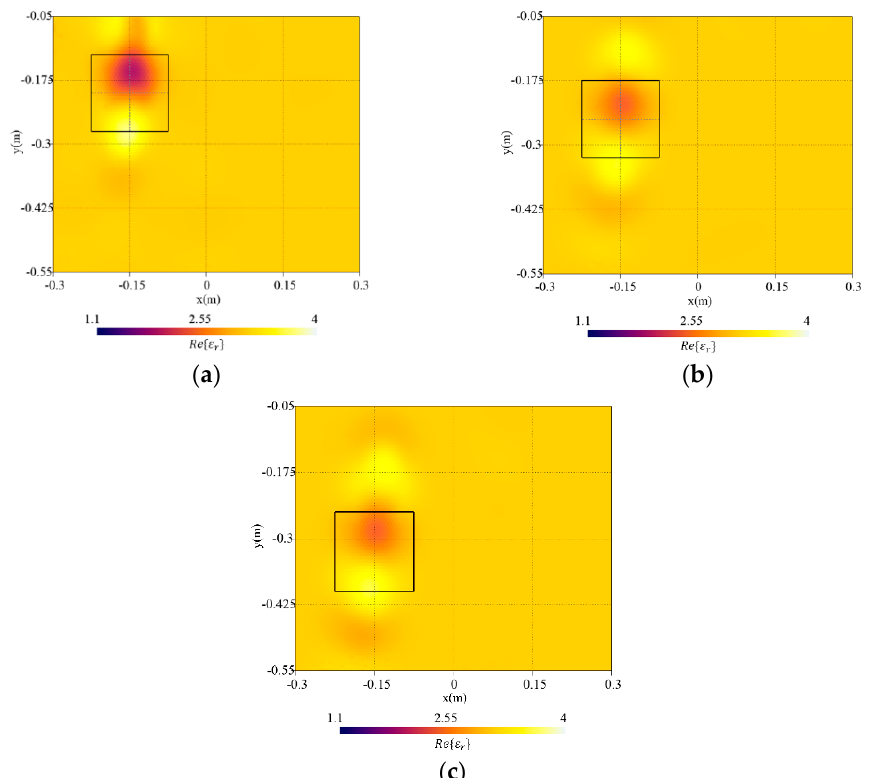
Figure 9. Reconstructed distribution of the real part of the reconstructed relative dielectric permittivity, Re { ε r } , in the investigation domain R together with a square box indicating the shape of the actual target. Target centered at ( a ) y t = − 20 cm, ( b ) y t = − 25 cm, and ( c ) y t = − 32.5